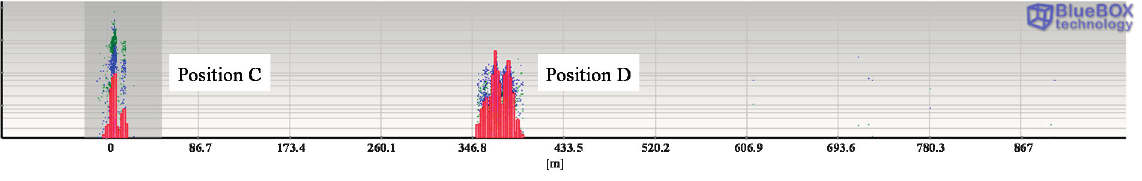
Figure 22. PD classification by location. PD sources located in positions C and D of the cable